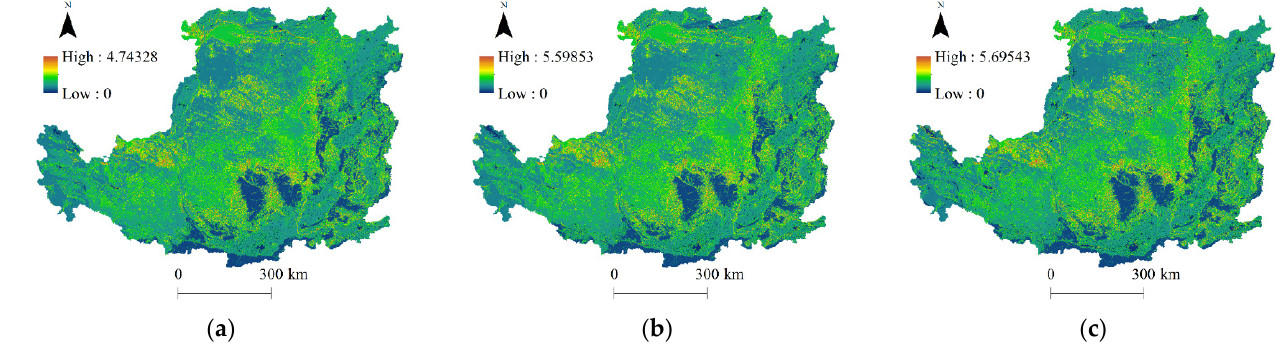
Figure 5. LERI of the Loess Plateau in ( a ) 2000, ( b )2010, and ( c ) 2020.